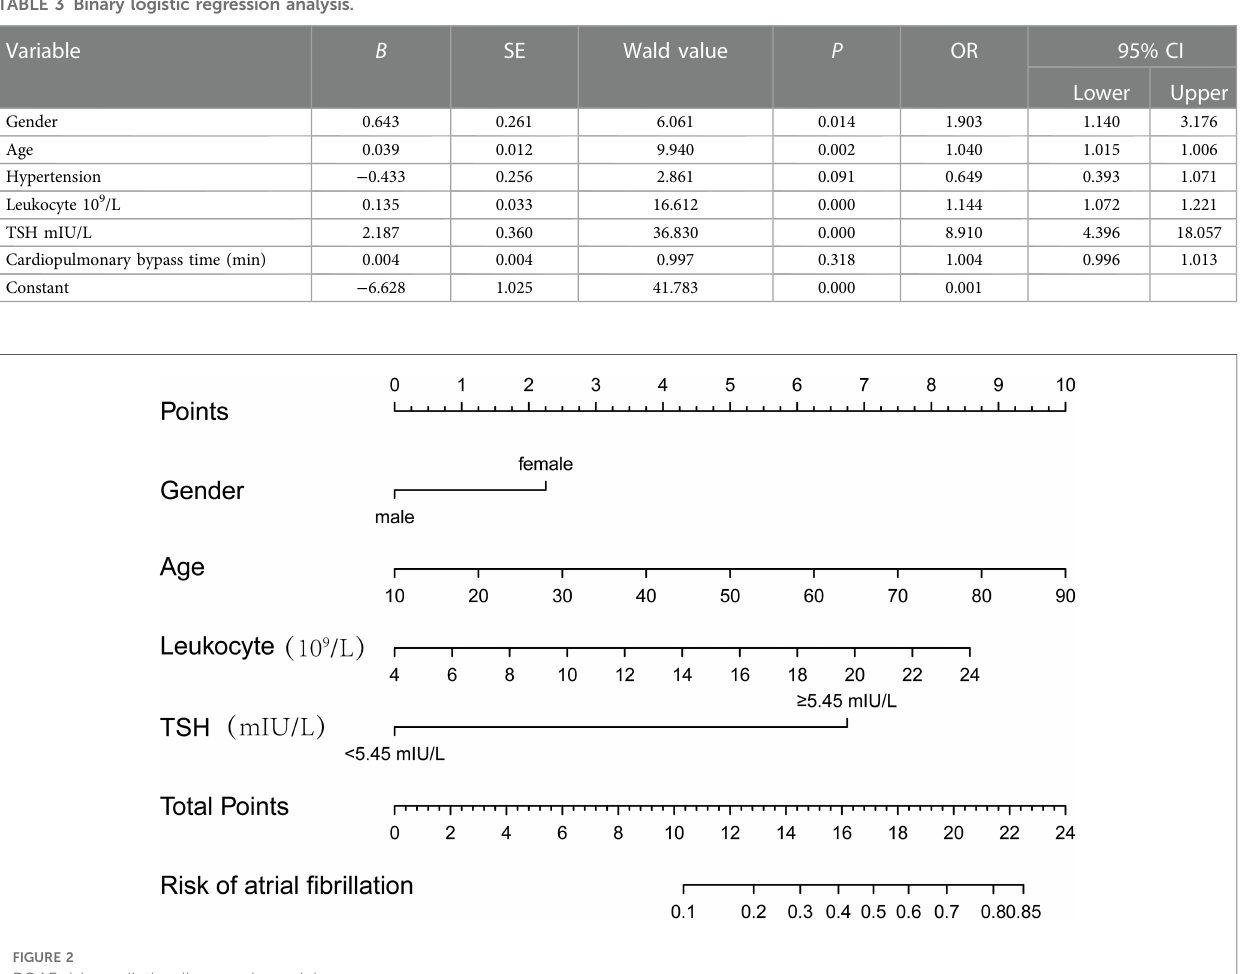
TABLE 3 Binary logistic regression analysis.